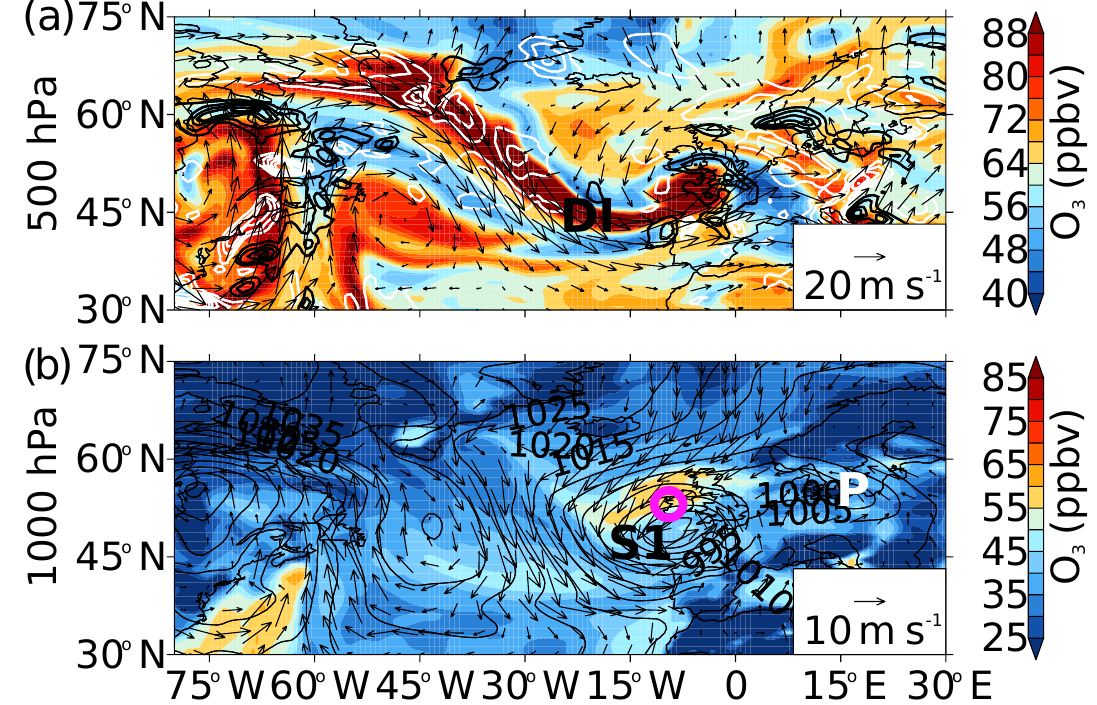
Figure 8. Synoptic conditions and O 3 distribution for the S1 cyclone ( b ; 12 ◦ N, 48 ◦ W) on 25 April 2012 at 00:00UTC, at the time of maximum ζ 850 . Two levels are shown: (a) 500hPa and (b) 1000hPa. Additional features are labeled, including the DI airstream ( a ) and the downstream decaying parent low to the S1 cyclone (white “P”, b ), and Mace Head is indicated (pink circle, b